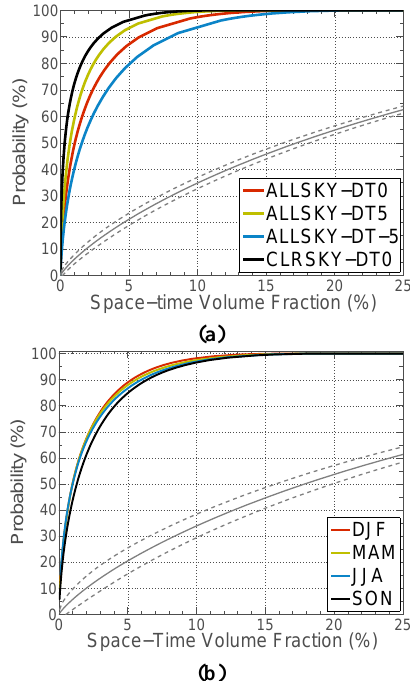
Fig. 5. Localization of the density distribution ρ 100hPa , as mea- sured by the cumulative fraction P % ( A ) , defined in Eq. (3.1.2). (a) Ensemble characteristics of P % ( A ) obtained from four CS-TTL tra- jectory ensembles, all launched at 100hPa. (b) Seasonal characteris- tics of P % ( A ) obtained from the ALLSKY- 1T 0 ensemble by con- sidering trajectories detrained during boreal winter (DJF), spring (MAM), summer (JJA) and fall (SON) seasons in 2005. For both (a) and (b) are plotted the mean (solid grey) and mean ± standard deviation (dotted grey) of P ˜ % ( A ) obtained from 1000 realisations of ˜ ρ 100hPa produced under uniform random